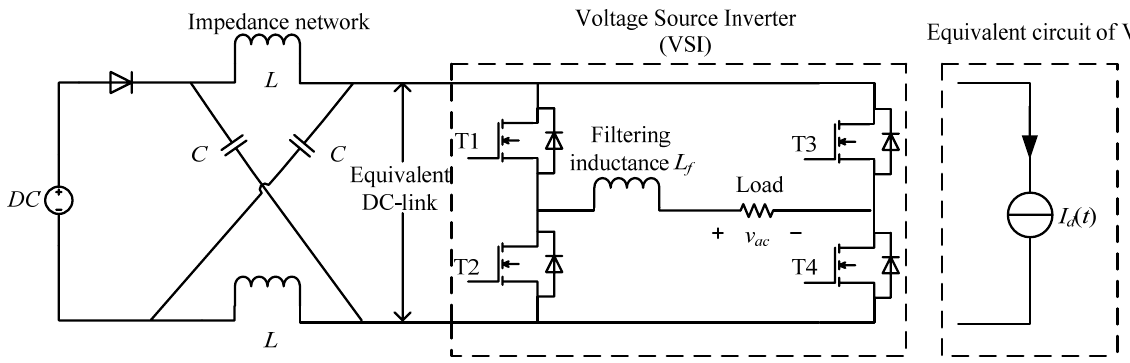
Figure 1. Single-phase full bridge Z-Source